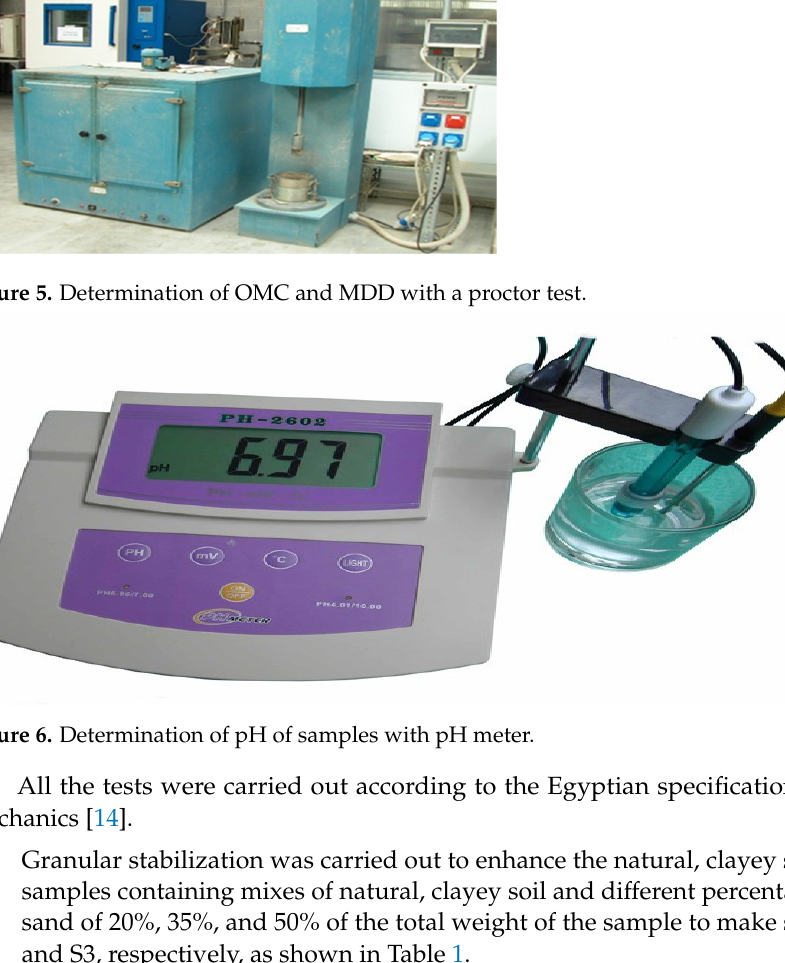
Figure 6. Determination of pH of samples with pH meter.